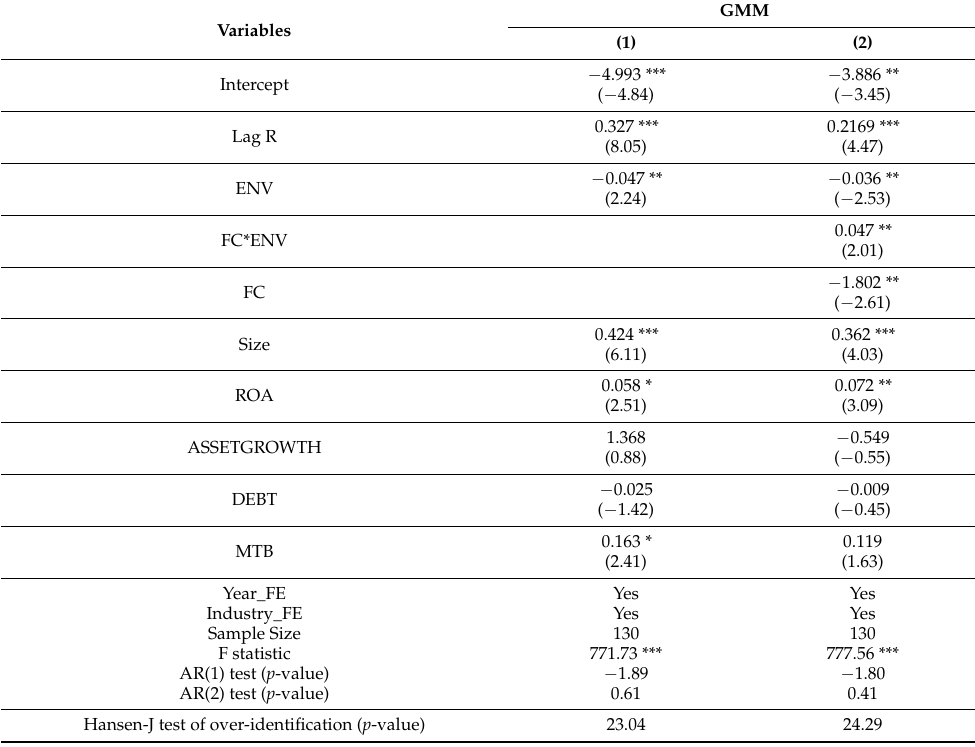
Table 7. Addressing endogeneity: generalized method of moments (GMM)